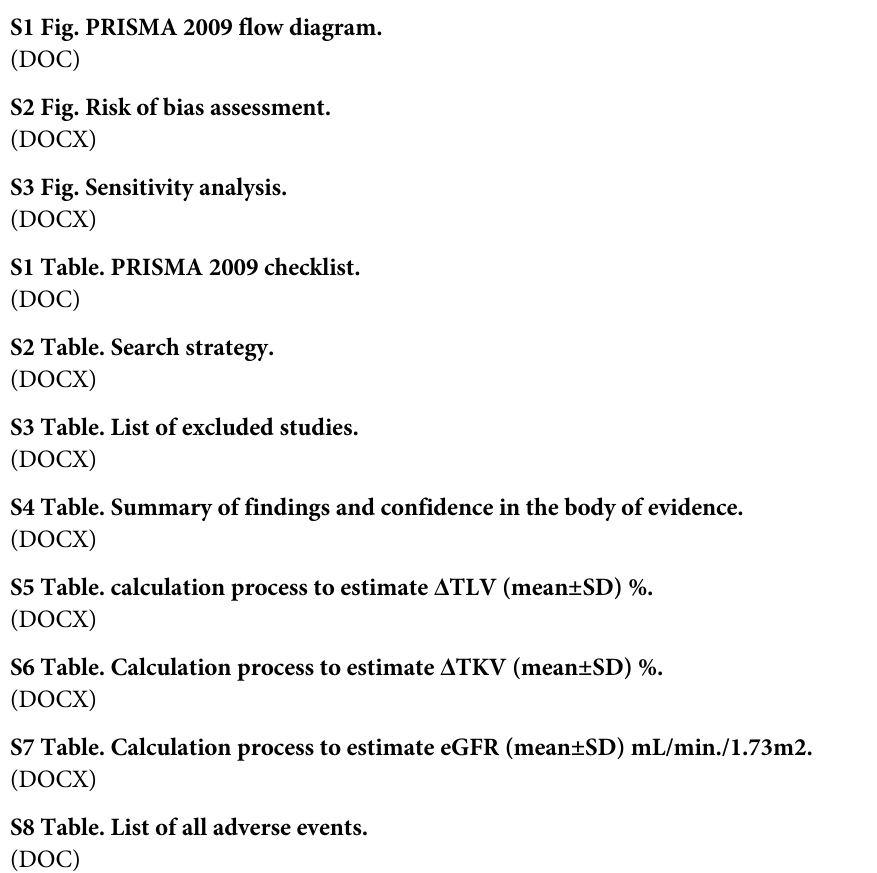
S1 Fig. PRISMA 2009 flow diagram.